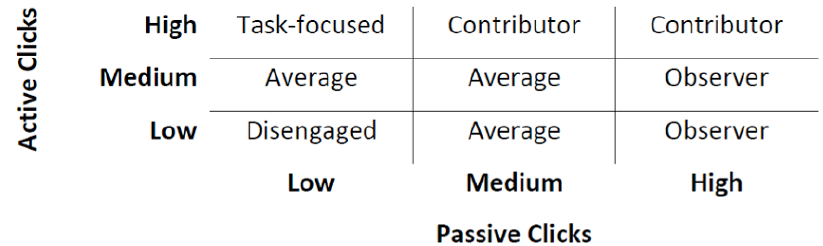
Figure 2 . Student interaction style.